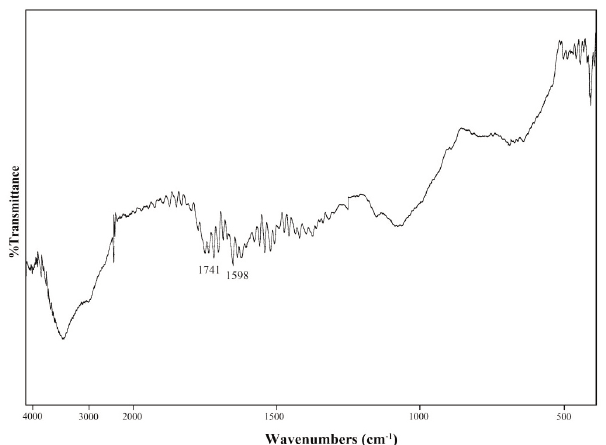
Fig. 3 - IR spectrum of magnetic nano-carboxymethylated chito- san. Transferring the absorbance band of -NH2 group from 1589 cm -1 to 1602 cm -1 and increasing absorbance intensity in wavelength number 1741 cm -1 show ester bond into some parts of carboxy groups in carboxy- methyl chitosan on the surface of Fe 3 O 4 nanoparticles.